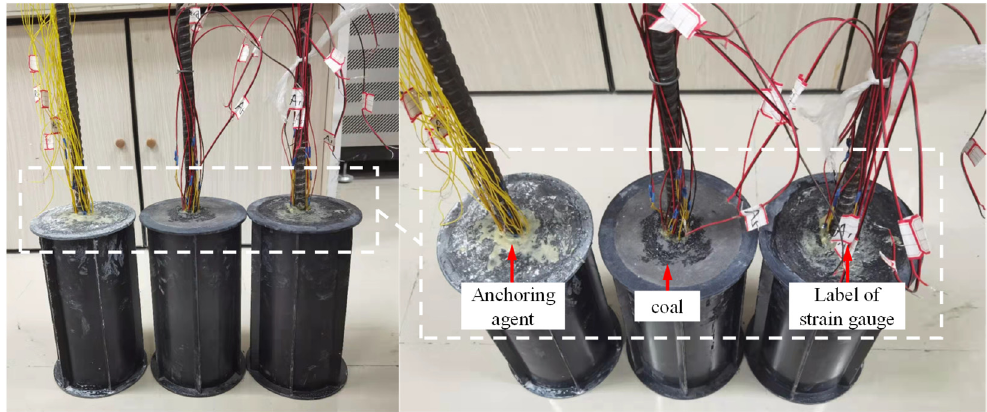
Figure 5. Prepared coal–rock combined anchoring pull-out test specimens (part).